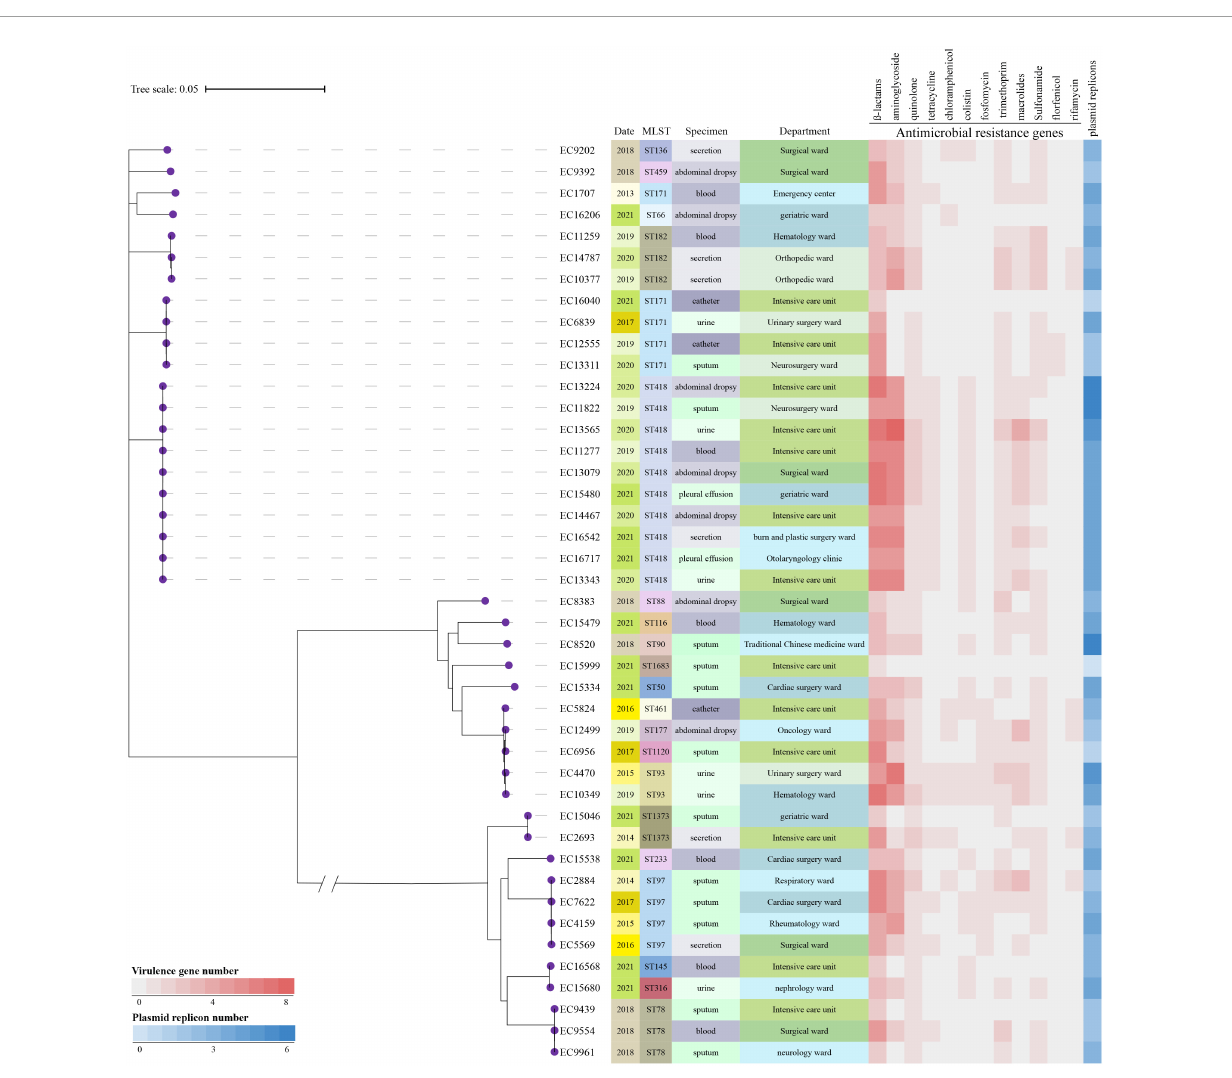
FIGURE3 Phylogenetic tree and heatmap of the 44 Enterobacter hormaechei isolates. Phylogenetic tree was constructed based on single nucleotide polymorphism alignment of genomes. MLST, multi-locus sequence typing.